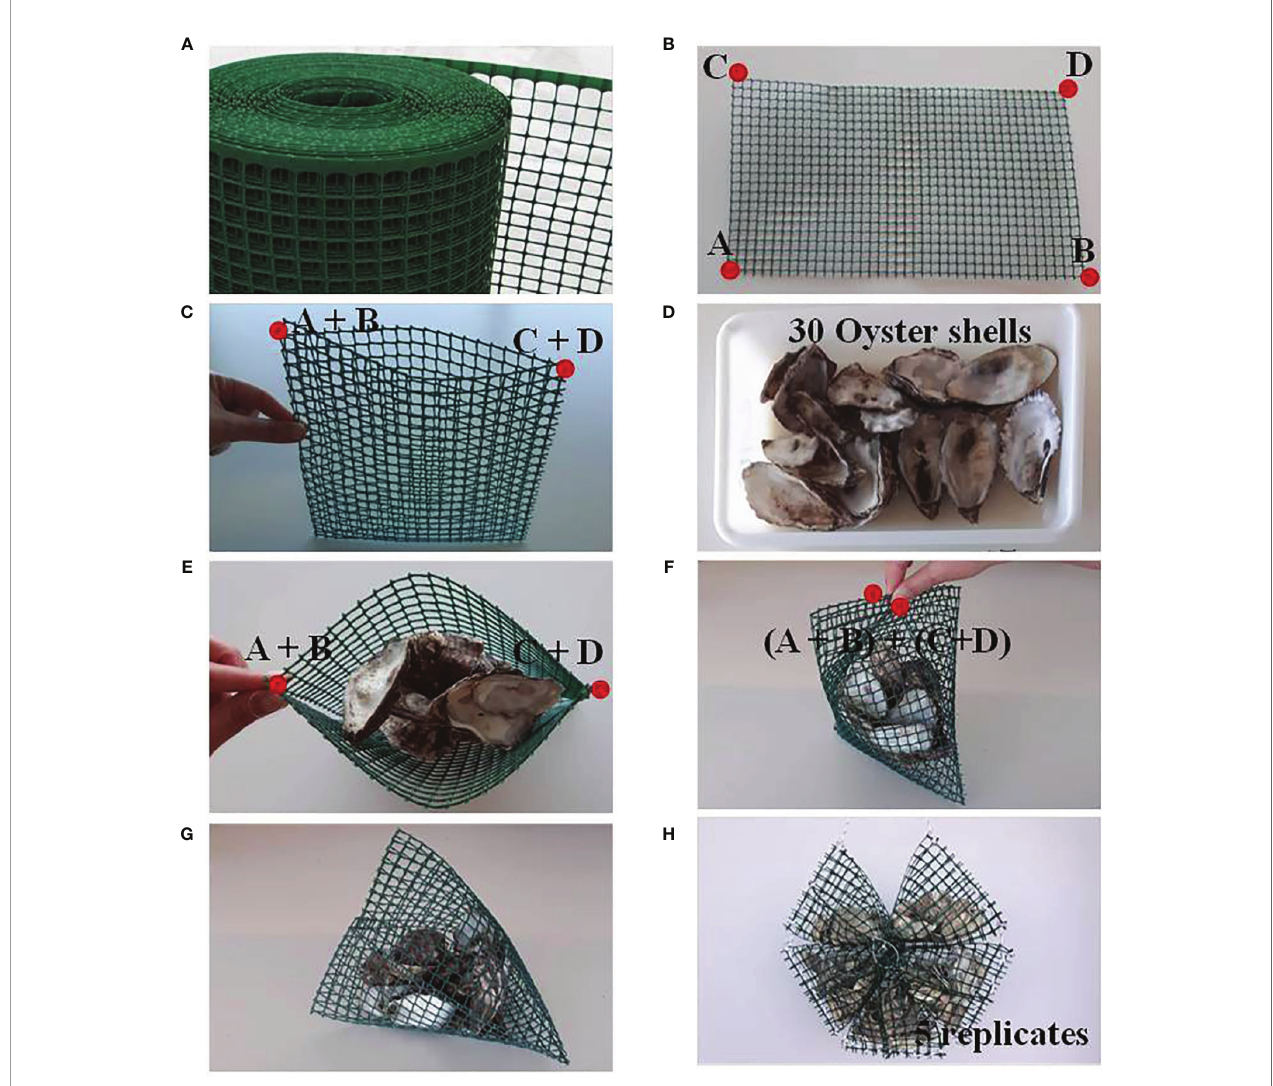
FIGURE 2 | Representation of the steps to set up the triangular-based pyramid (A – G) and the fi nal star-shaped arti fi cial substrate unit (ASU) consisting of fi ve replicates (H)